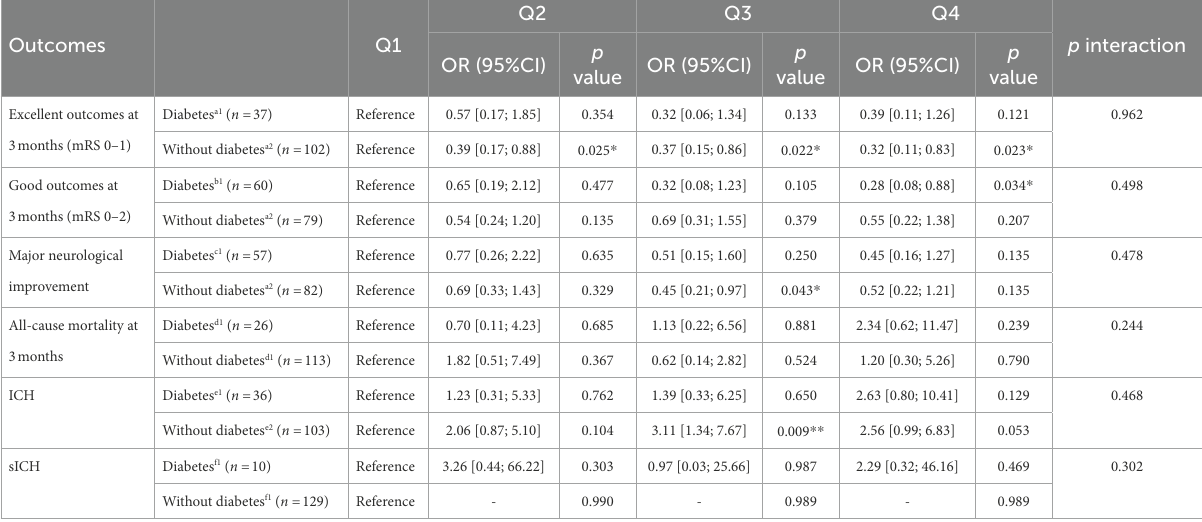
TABLE 3 SHR status in relation with neurological function outcomes, mortality or hemorrhage in participants with and without diabetes.